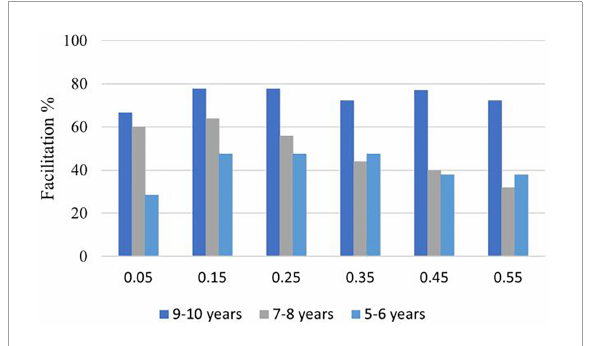
FIGURE8 The percentage of participants in each group who show faster MRTs for AVS than AS+VS CDF predicted by the race- model at each of the six